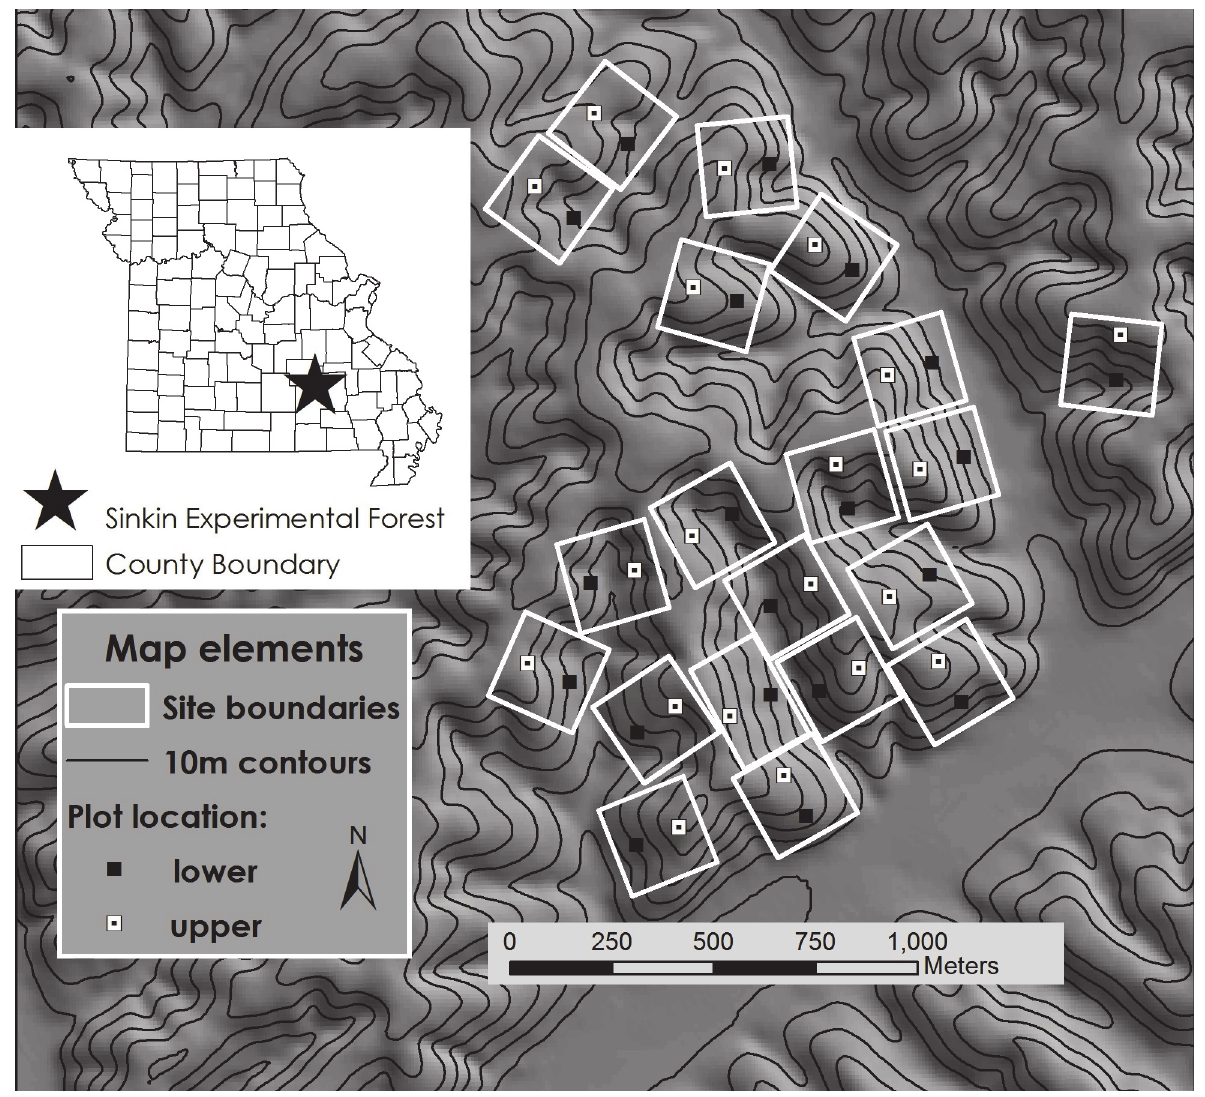
Fig 1. Location of study site in Dent County, Missouri, USA (inset) and relief map of 20 experimental units that were surveyed for red-backed salamanders from spring 2010 — fall